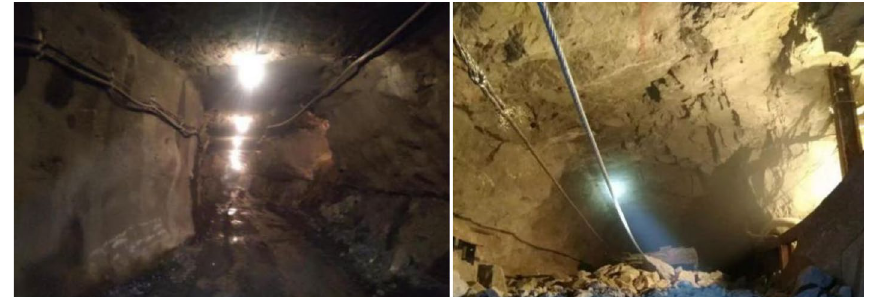
Figure 1. Rough surface.